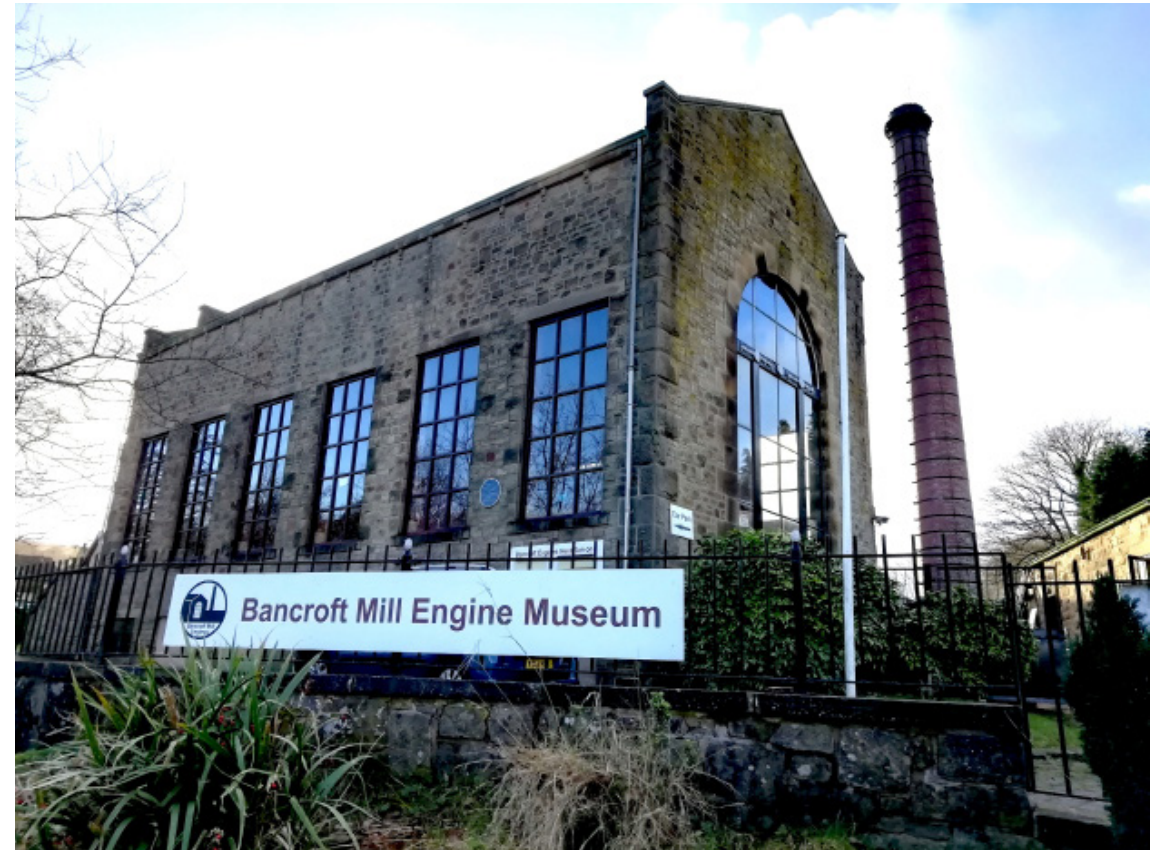
Figure 1. The architecturally impressive steam engine house of the demolished Bancroft’s Textile Mill, now preserved as a museum, gives an indication of the historic importance of Barnoldswick in the textile industry. The preserved chimney is 135 feet